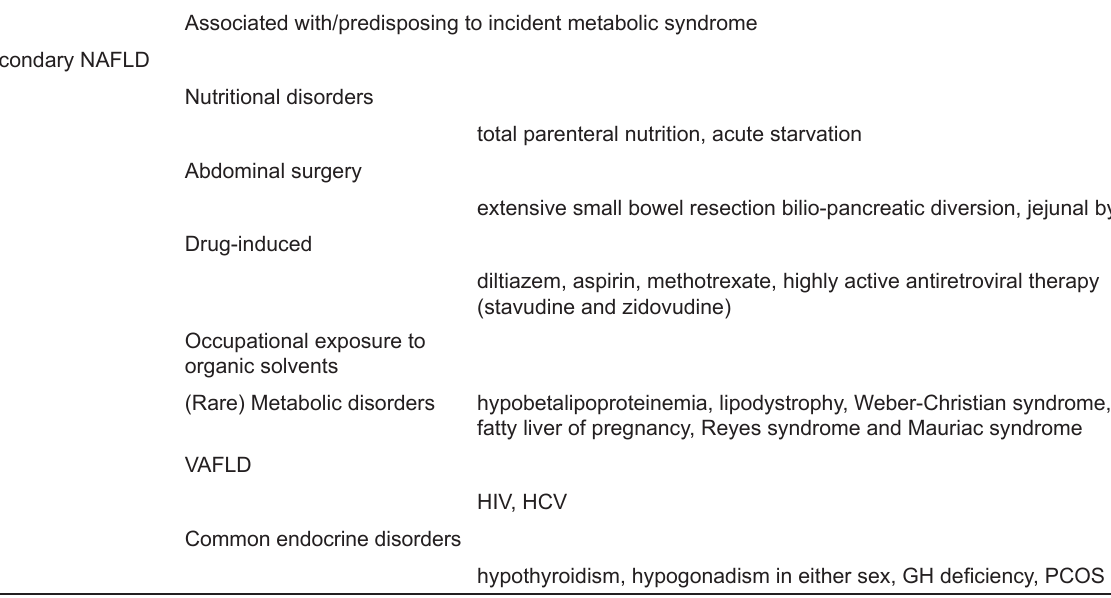
Table 1. Classification of NAFLD [ 2, 3] Primary NAFLD Associated with/predisposing to incident metabolic